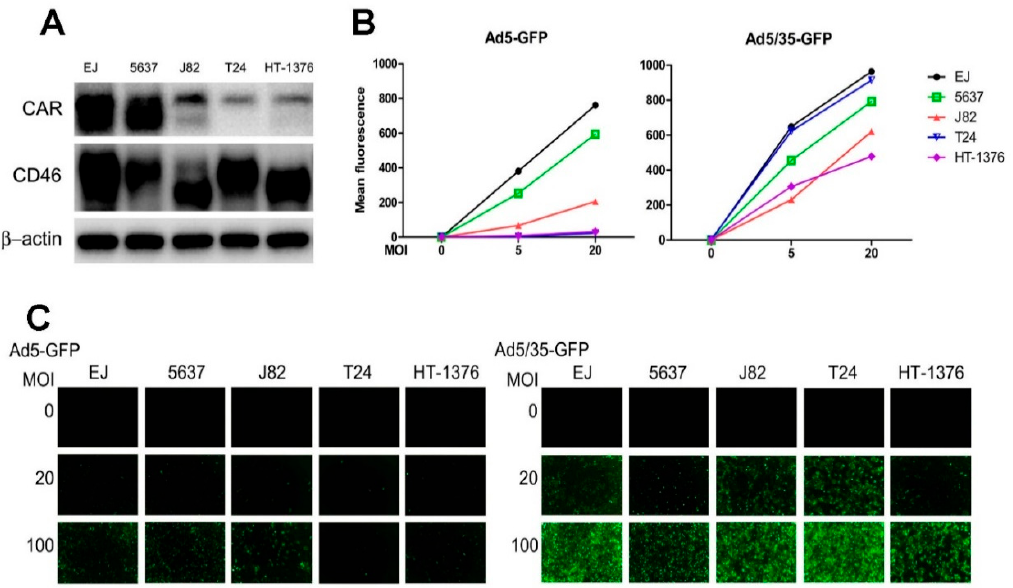
Figure 4. CD46 expression analysis and Ad5/35-mediated gene transduction in bladder cancer cell lines. ( A ) CAR and CD46 expression levels were analyzed in bladder cancer cell lines by Western blot analysis. ( B ) Transduction analyses of bladder cancer cell lines by flow cytometry following infection with different doses of Ad5-GFP or Ad5/35-GFP. ( C ) Transduction analyses of bladder cancer cell lines by fluorescence microscope following infection with the indicated multiplicities of infection (MOI) of Ad5-GFP or Ad5/35-GFP. At 24 h post-infection, GFP expression levels were monitored (20 ×).